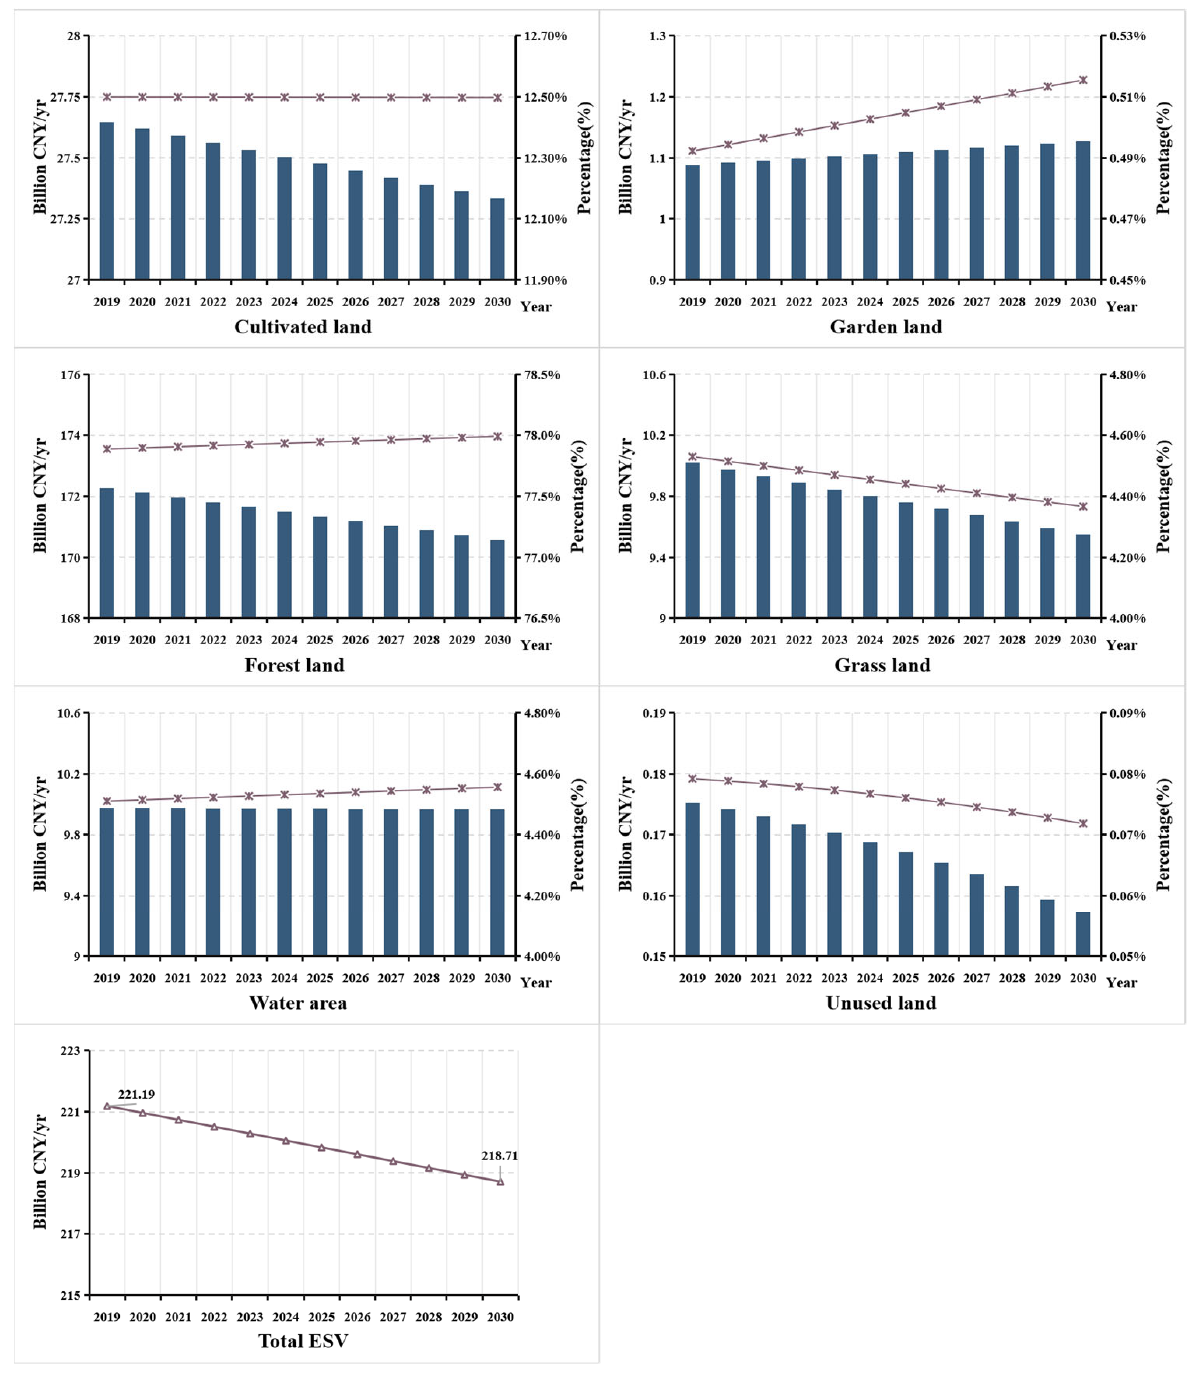
Figure 6. Forecast changes of ecosystem services value of different land use types in Guizhou Prov ‐ ince from 2019 to 2030.